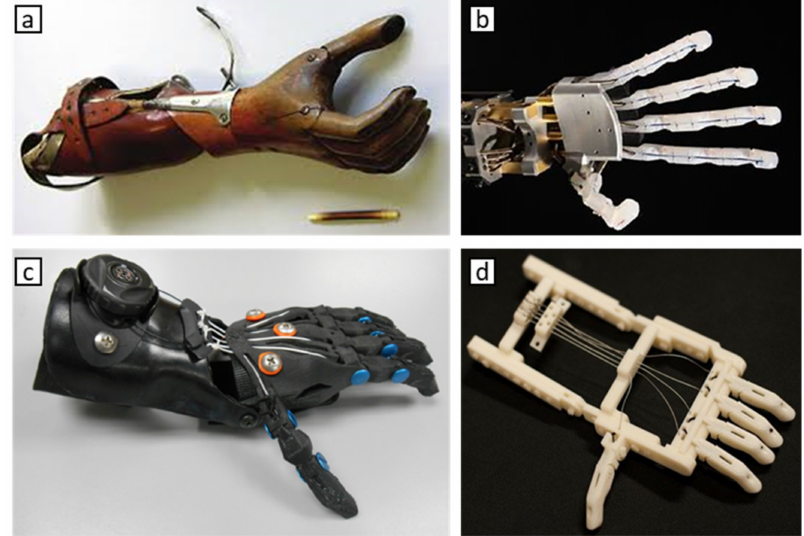
Figure 1. Some models of mechanical prostheses. ( a ) Mechanical prosthesis of the early 20th century [2], ( b ) hand gesture robot [3], ( c ) a low-cost 3d-printed prosthetic hand [4], ( d ) the world’s first 3D-printed upper-extremity prosthesis device